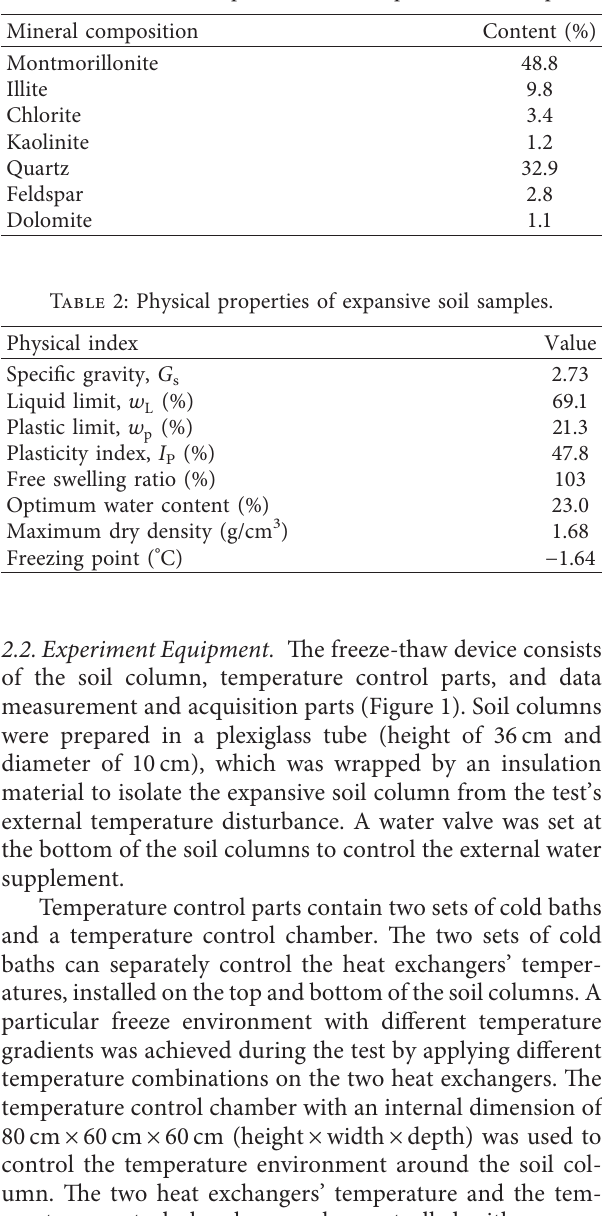
Table 1: Mineral composition of the expansive soil sample.